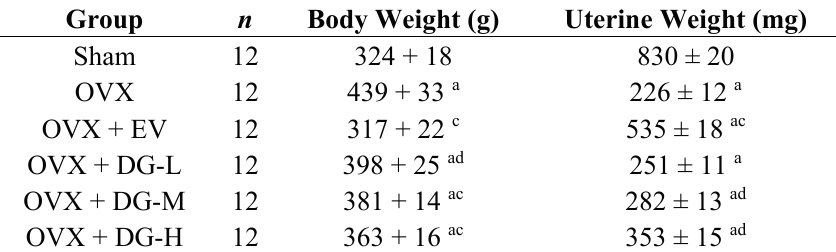
Table 1. Comparison of body weight and uterine weight among groups after 12-week treatment. Group n Body Weight (g) Uterine Weight (mg)